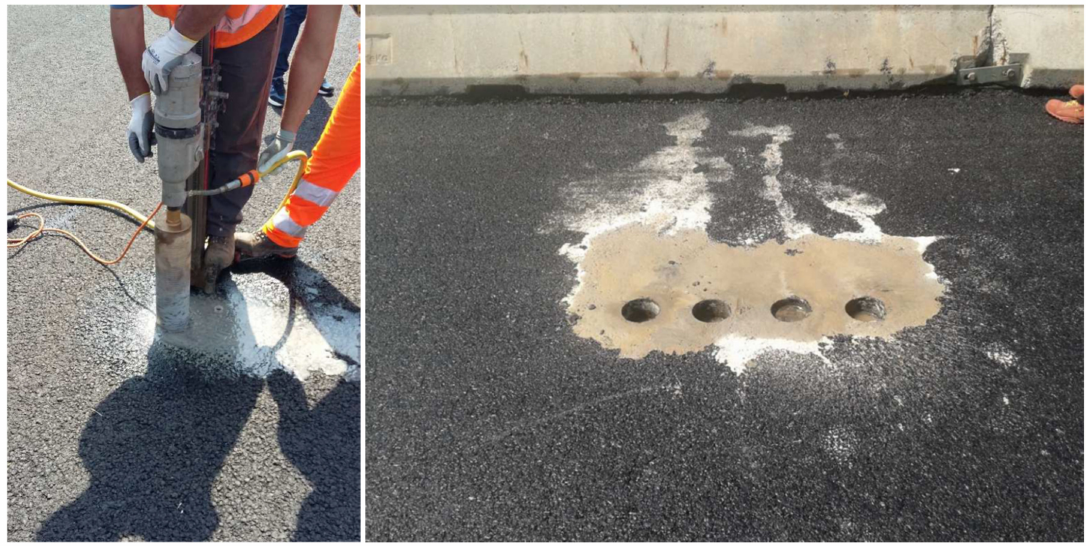
Figure 6. Taking cores for the quality assurance and in-place mixtures properties.